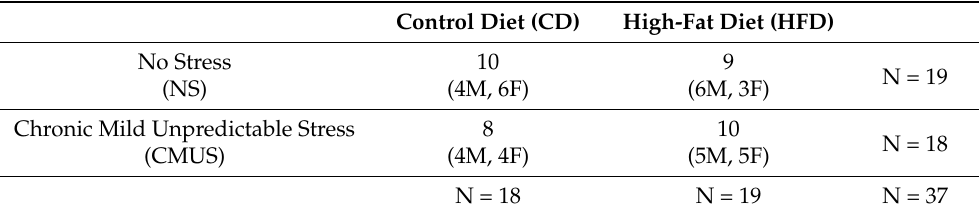
Table 1. Experimental sample